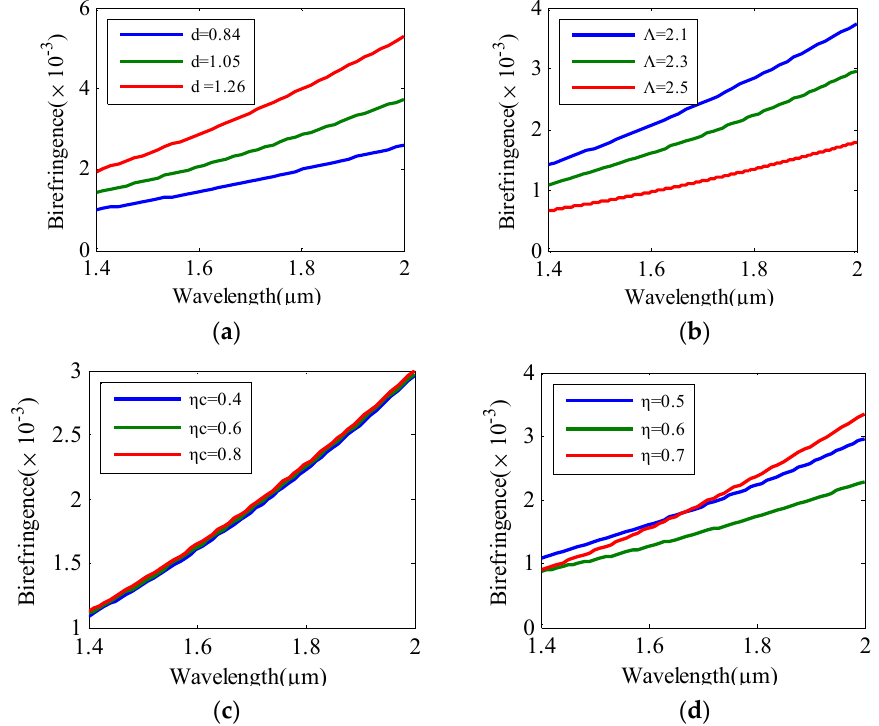
Figure 6. Variation of birefringence in the proposed dual-core PCF. ( a ) Birefringence at different d/ Λ with varying wavelength. ( b ) Birefringence at different Λ with varying wavelength. ( c ) Birefringence at different η c with varying wavelength. ( d ) Birefringence at different η with varying wavelength.